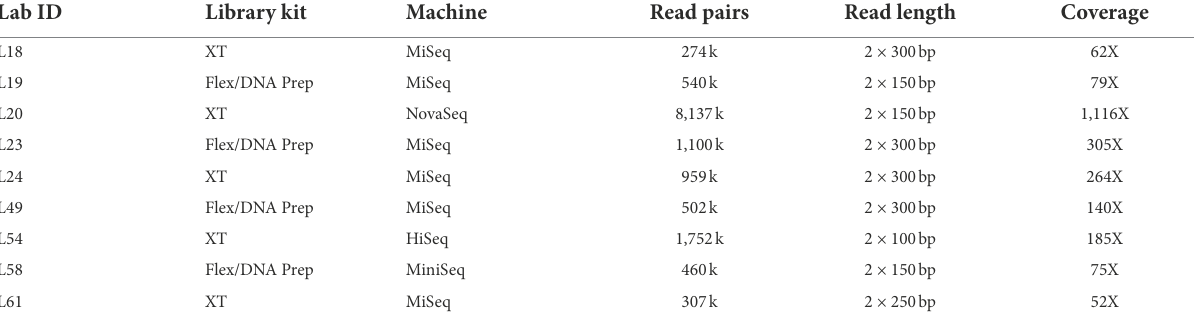
TABLE 1 Overview of the partial dataset from EURL-Campylobacter proficiency test number 28 analyzed in this study. Lab